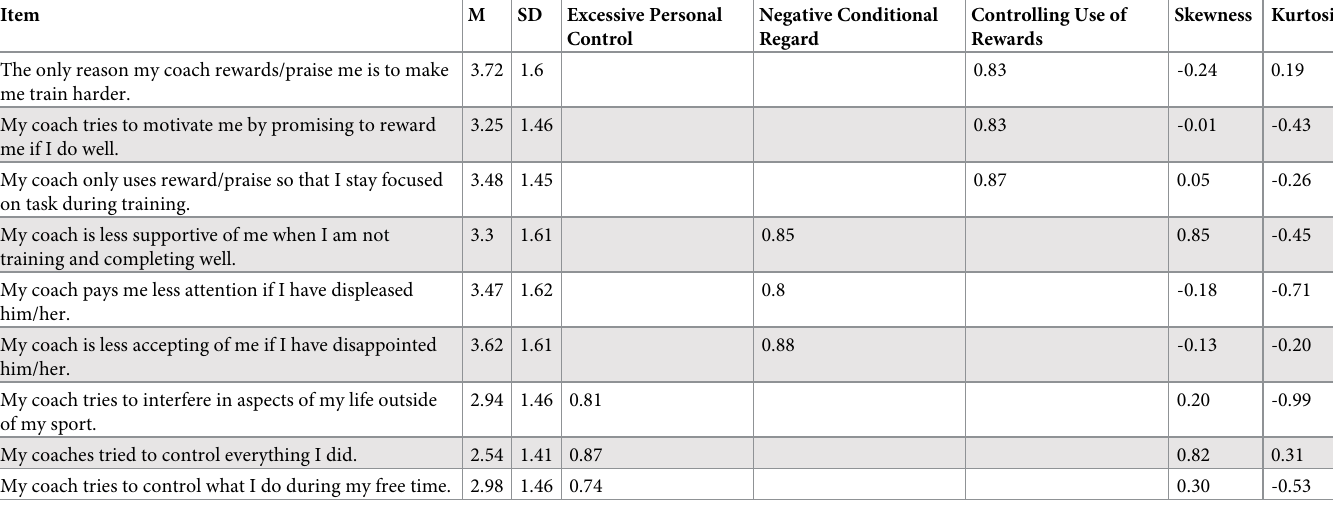
Table 2. Item means, standard deviation, factor loadings, and skewness and kurtosis value following exploratory factory analyses (Study 1). Item